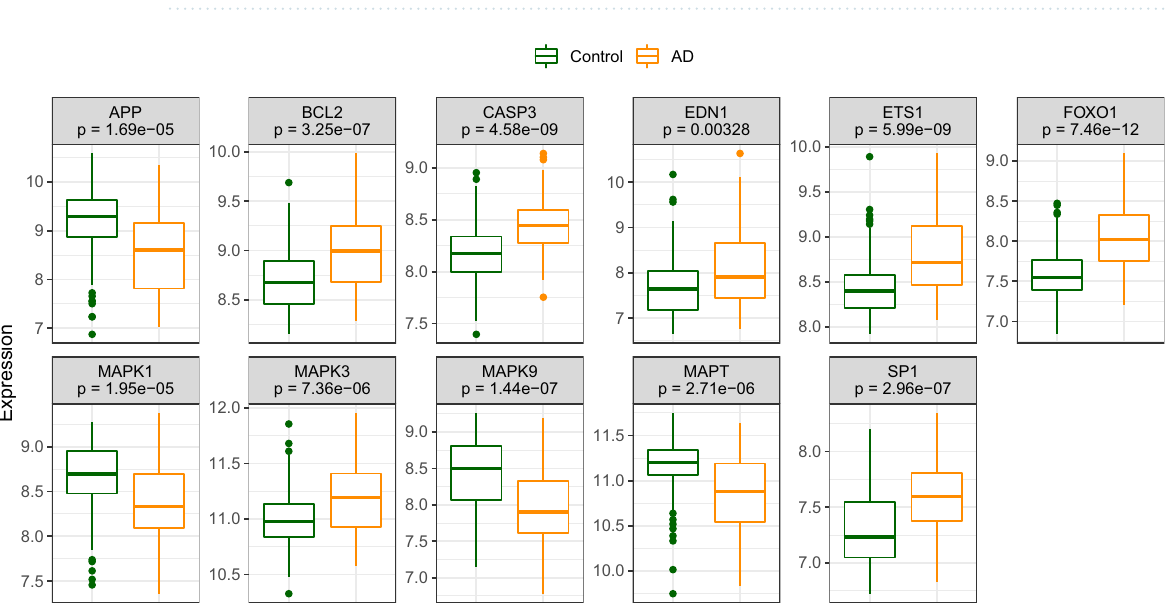
Figure 11. ( a ) Protein–protein interaction network constructed from candidate hub genes. ( b ) Hub sub- networks.